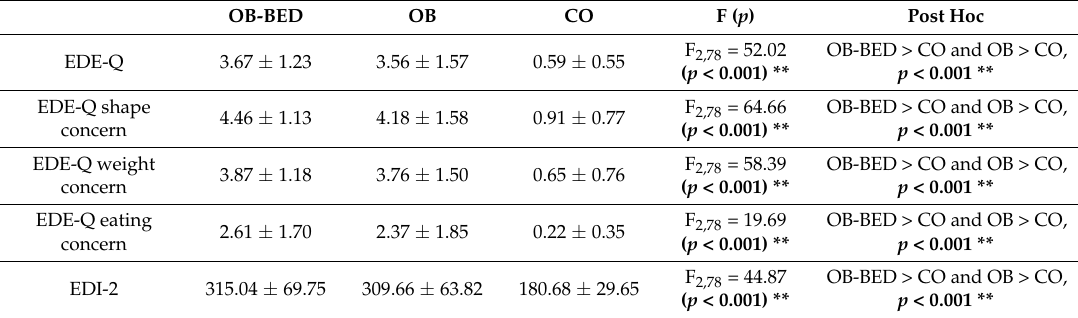
Table 2. Comparisons (MANOVA) between OB-BED, OB, and CO with regard to self-reports using the EDE-Q and the EDI-2 (total scores and subscales). Meal intake of inpatients in this study was monitored by caregivers during inpatient treatment; thus, the subscale “restraint” of the EDE-Q was not applicable (for more details see main text). OB-BED = patients with obesity and current BED, OB = subjects with obesity without binge eating episodes, CO = norm-weight controls without self-reported lifetime eating disorder